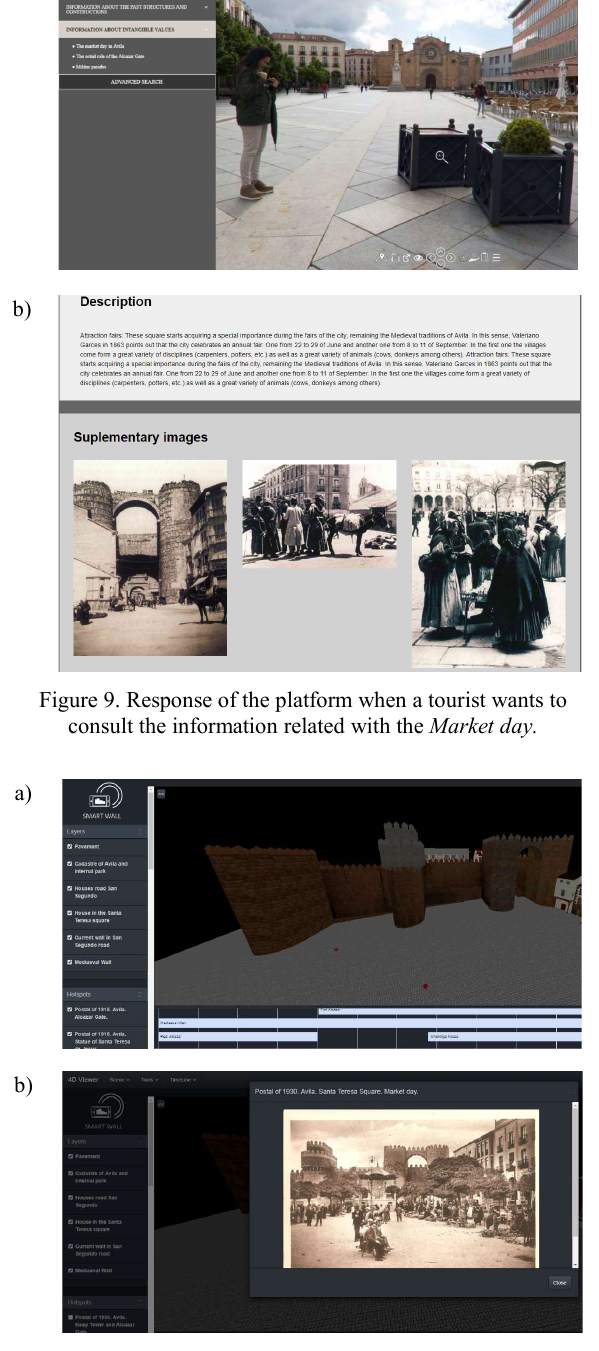
Figure 10. Result of the 4D viewer when the user consults the information related with the Market day: a) general view of Alcázar Gate in 1930; and b) result of consulting a 3D hotspot related with the market